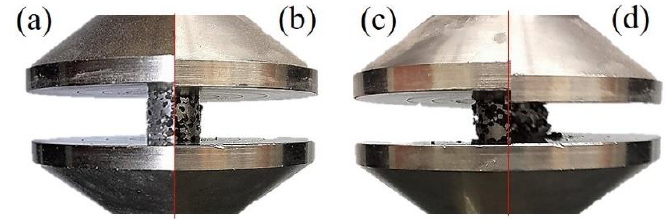
Figure 8. Example of sample behavior during uniaxial compression test: ( a ) pre-stress; ( b ) plastic collapse; ( c ) deformation during plateau stress; and ( d ) densification.